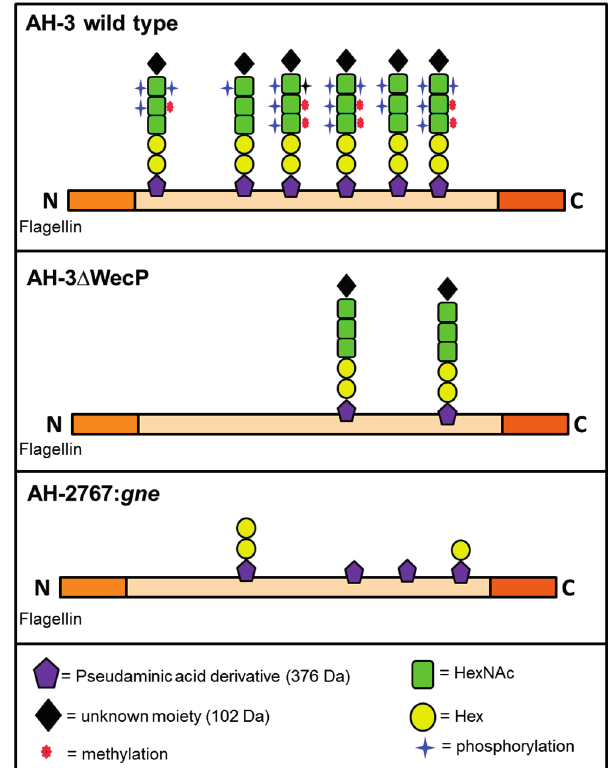
Figure 2. Schematic representation for the polar flagellin glycosylation of the wild type, and mutants AH-3 Δ WecP and AH-2767: gne